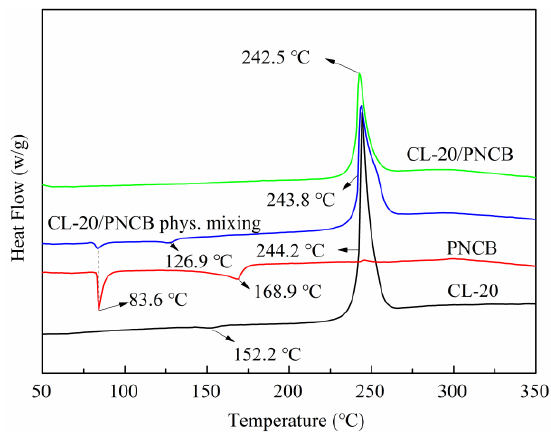
Figure 4. DSC curves for CL-20, PNCB, mixed CL-20/PNCB, and the CL-20/PNCB composite.